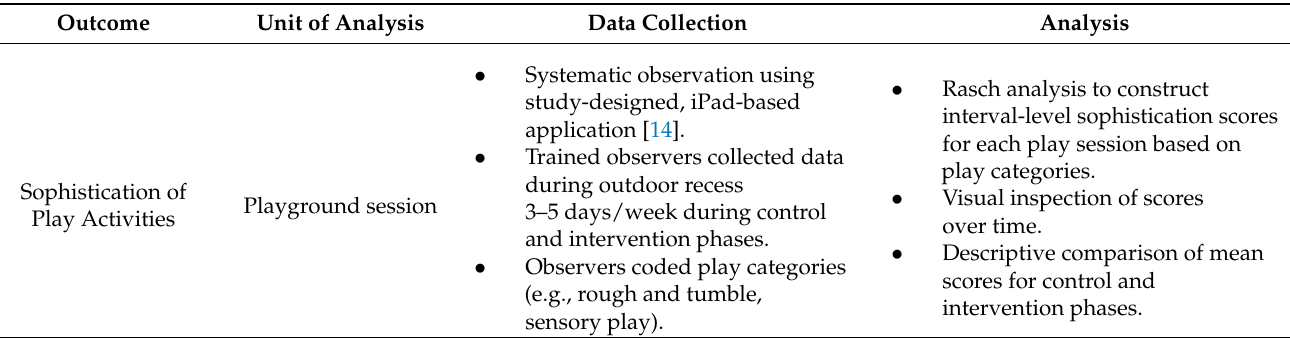
Table 1. Quantitative outcome measures and